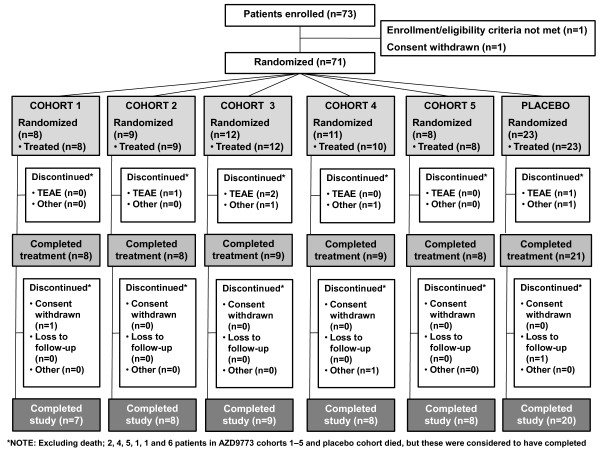
Patient disposition.